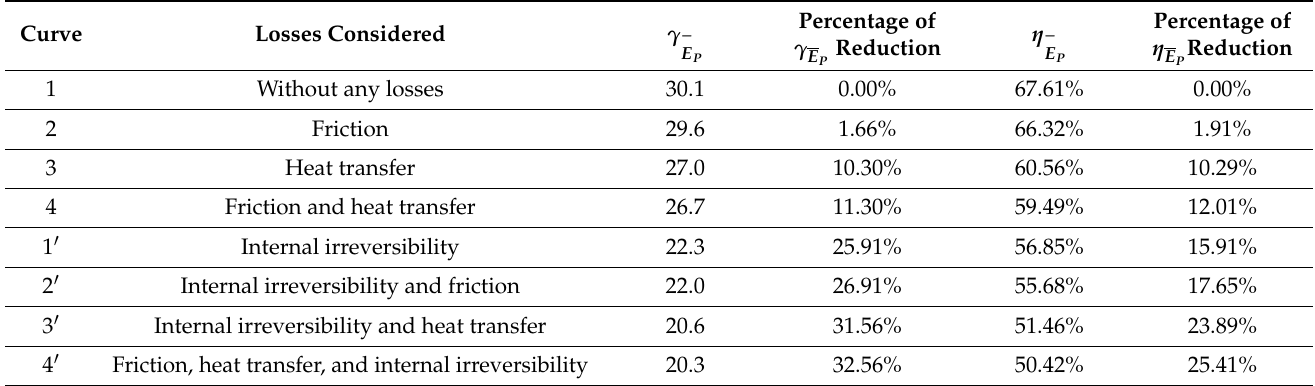
and η when considering different losses. E P E P